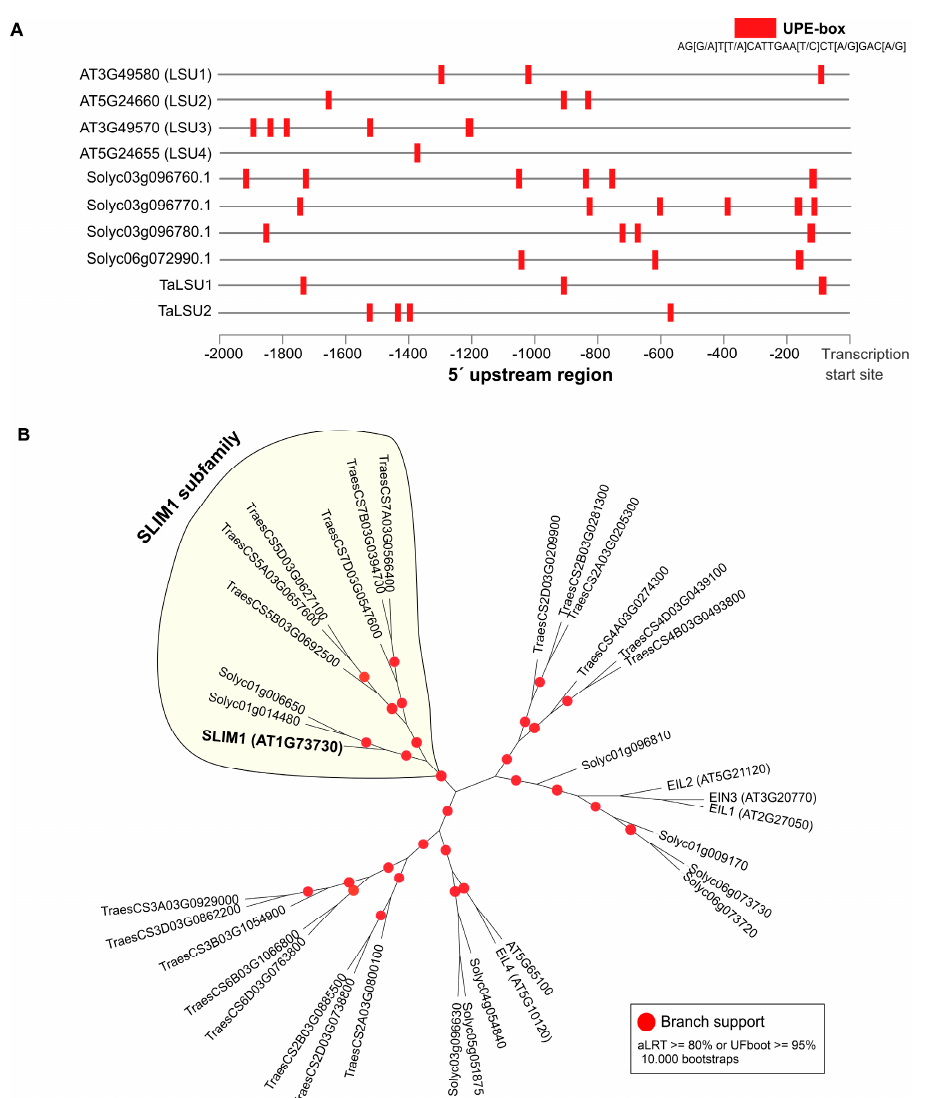
Figure 6. Distribution across promoters of the Arabidopsis, tomato and wheat LSU genes of the UPE-box element involved in S response. The promoter region was defined as the 2-kb sequence upstream of the transcription start site (based on Ensembl Plants v52) of each LSU gene ( A ). Phylogenetic analysis shows that ortholog genes of the Arabidopsis SLIM1 are present in tomato and wheat genomes ( B ). SLIM1 is a well-known transcription factor that binds to the UPE-box elements [19,44].